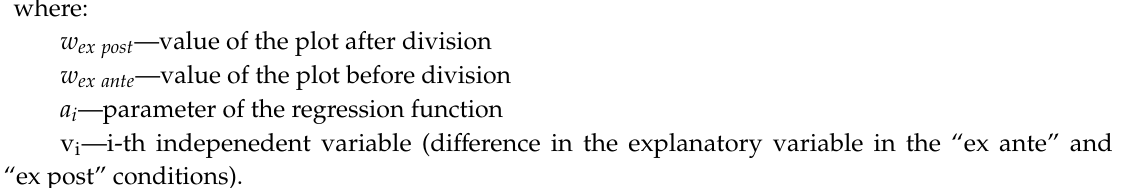
Stage 7: We created a non-linear model and simulation of the “ex post” plot value based on the “ex ante” value and found the di ff erence in the attributes in the “ex ante” and “ex post” conditions (the attributes are presented in Table 1) according to Equation (6):